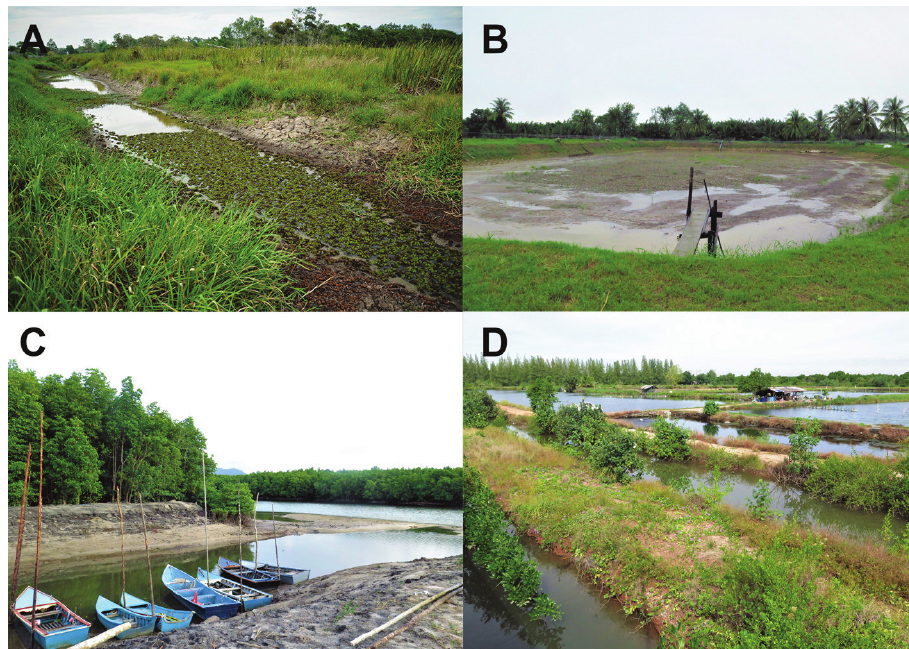
Figure 7. Exemplar habitats in Thailand of A Fejervarya cancrivora at a wetland in Khuan Khanun Dis- trict, Patthalung Province B F. cancrivora at a brackish shrimp pond near Pak Phanang river, Pak Phanang District, Nakhon Si Thammarat Province C F. moodiei at mangrove forest in Thai Mueang Distrinct, Phang-nga Province, and D F. moodiei at brackish fish ponds near mangroves at the mouth of the Prasae River, Kleang District, Rayong Province. Photograph A by Attapol (3) skin on dorsum and flank with spinules, and glandular warts, with irregular skin folds not arranged in series, with darker marking on dorsal surface of forelimbs and hindlimbs; (4) relative finger lengths II < IV < I < III; (5) Most individual have dermal fringe on fingers II and III; (6) prepollax indistinct; (7) palmar tubercles indistinct; (8) foot moderately webbed, with webbing formula I1–11/2II1–2III1–2IV2–1V; (9) der-